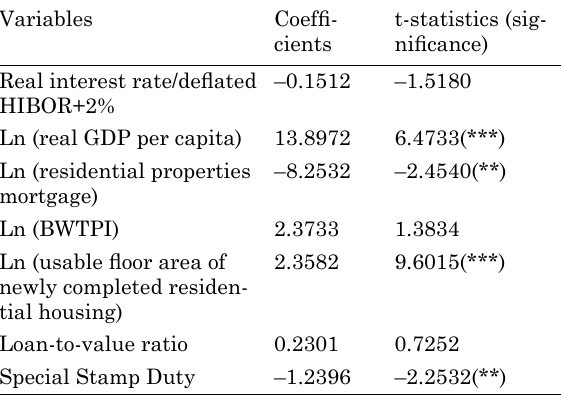
Table 4. The cointegrating coefficients with